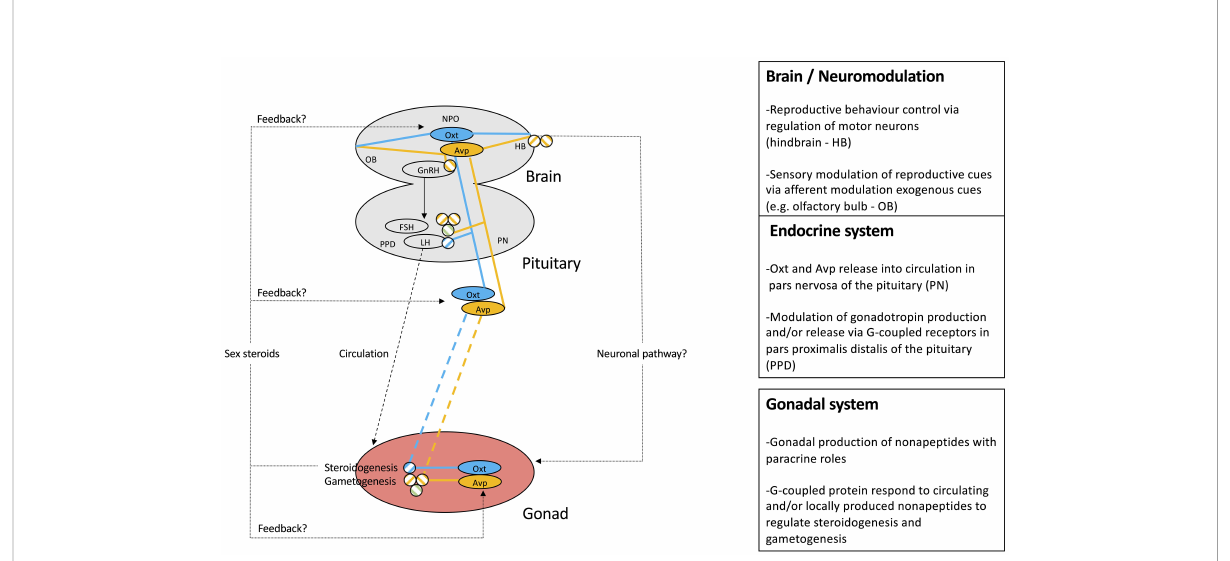
FIGURE 4 Schematic representation of mechanistic knowledge of nonapeptide roles in teleost reproduction. The Avp system is highlighted in yellow, while the Oxt system is represented in blue. Circled nonapeptides indicate sites of synthesis, while connecting lines represent neuronal, endocrine, and paracrine pathways. Speci fi c receptor involvement in regulatory function of HPG axis components is symbolized as de fi ned in Figure